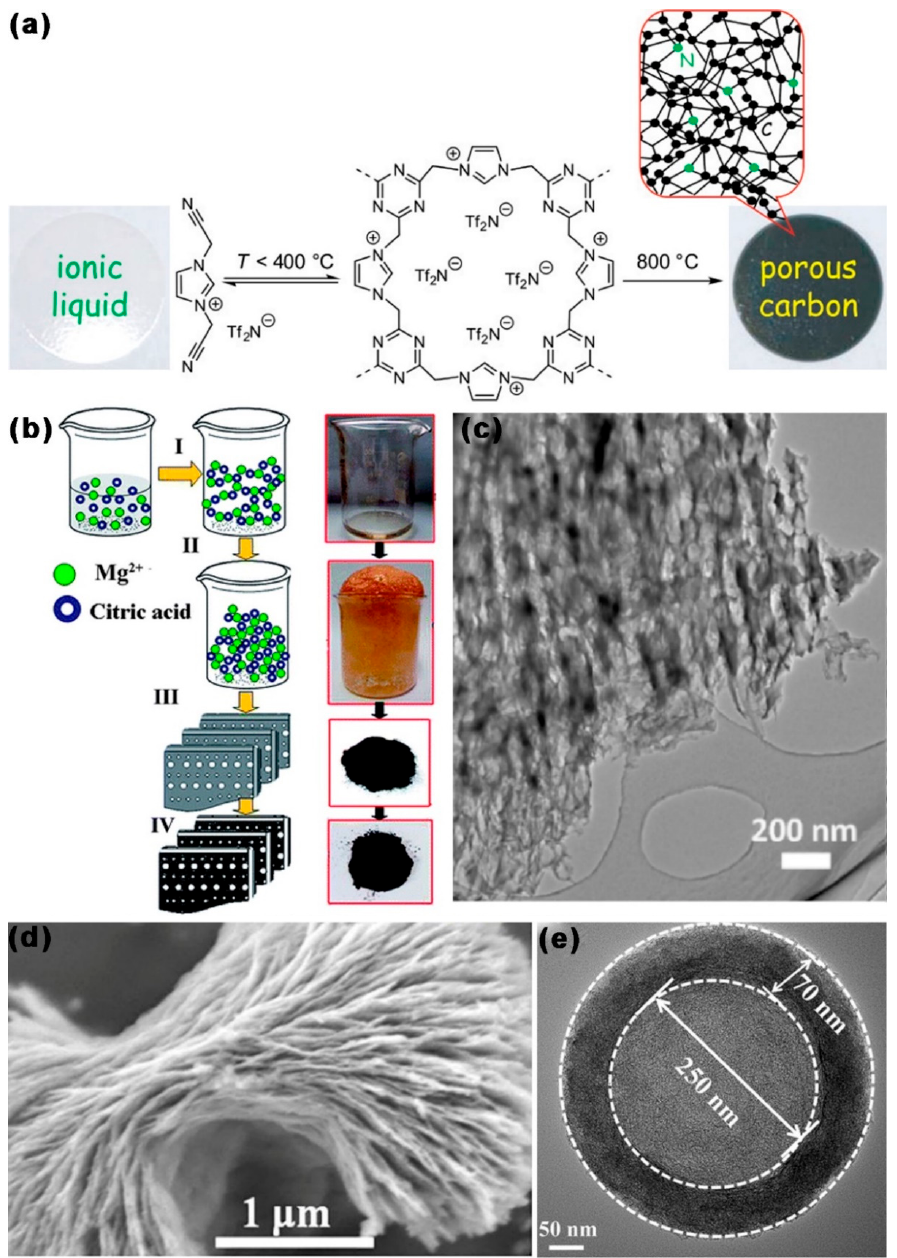
Figure 6. Schematic diagram and TEM images of MCBM prepared by the template-free method: ( a ) The preparation process of [MCNIm][Tf 2 N] [76]. ( b ) The MCF is prepared using the Pechini technique [77]. ( c ) TEM micrographs of NC700 [81]. ( d ) SEM images of FC4 hierarchical porous carbon [79]. ( e ) High-resolution TEM (HRTEM) of the N/S-HMCS900 [80].